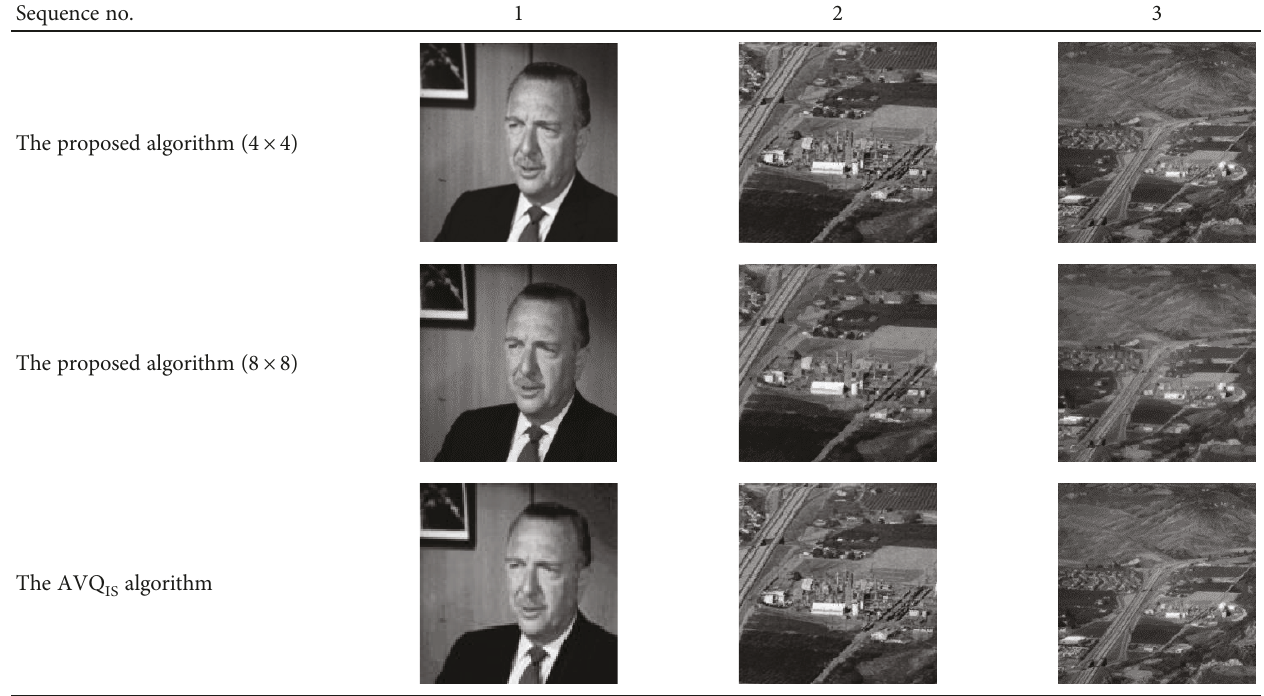
Table 8: Comparison of decoding e ff ects of proposed algorithms and the AVQ Sequence